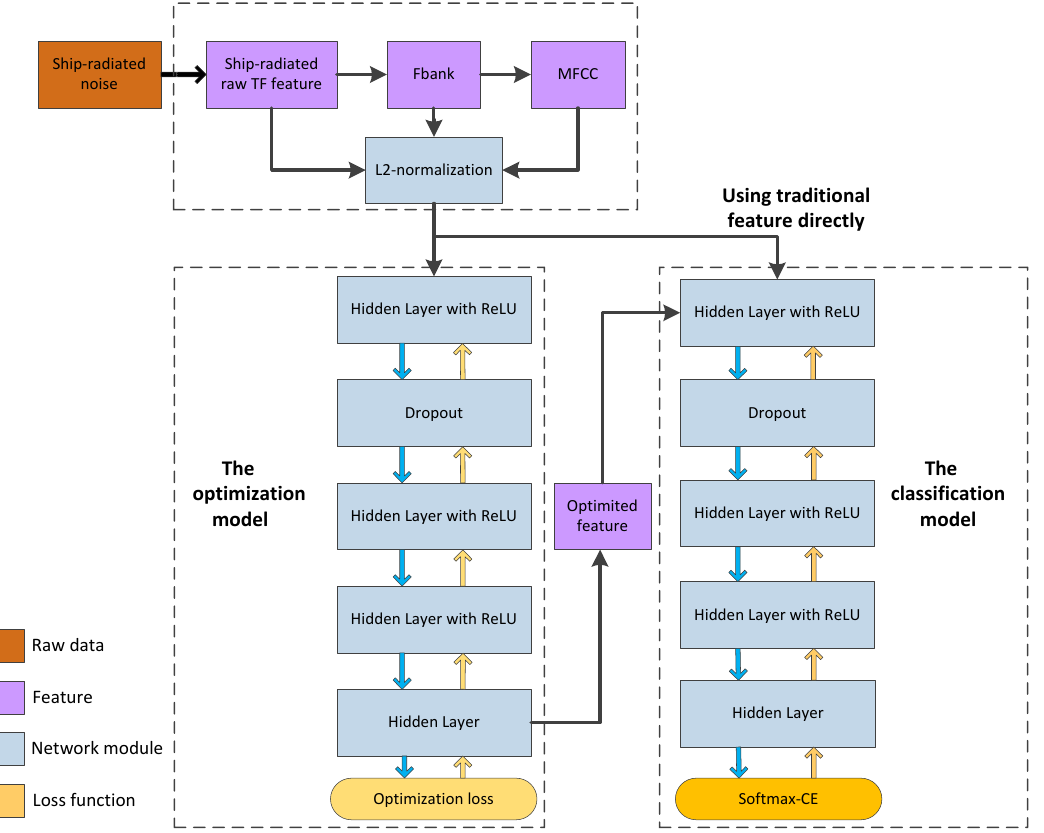
Figure 3. An overview of architecture for joint training. We adopt multilayer DNN as the basic component for achieving representations of ship types, and the proposed optimization loss is used as the supervision loss. In addition, softmax loss could be also combined into the framework for boosting performance. The blue arrow and yellow arrow present forward propagation and backpropagation